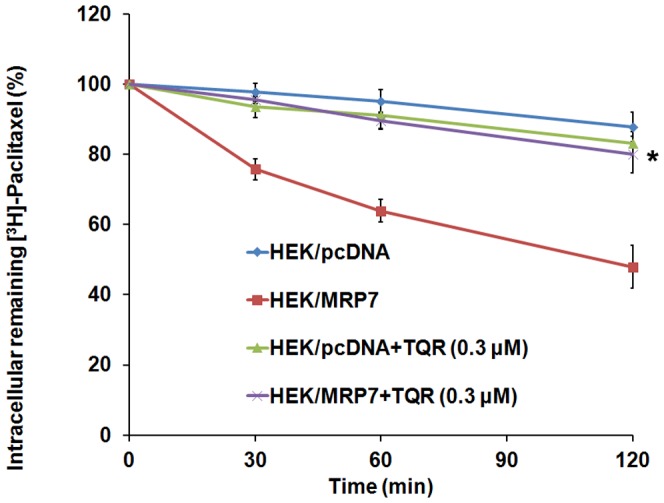
Effect of tariquidar on the efflux of paclitaxel in HEK/pcDNA and HEK/MRP7 cells.The efflux assay was performed as described in Materials and Methods. The values at 0 min were set as 100%. Each data point represents the mean ± SD of three independent experiments, each performed in triplicates. *P<0.05, versus HEK/MRP7 cells without tariquidar treatment.